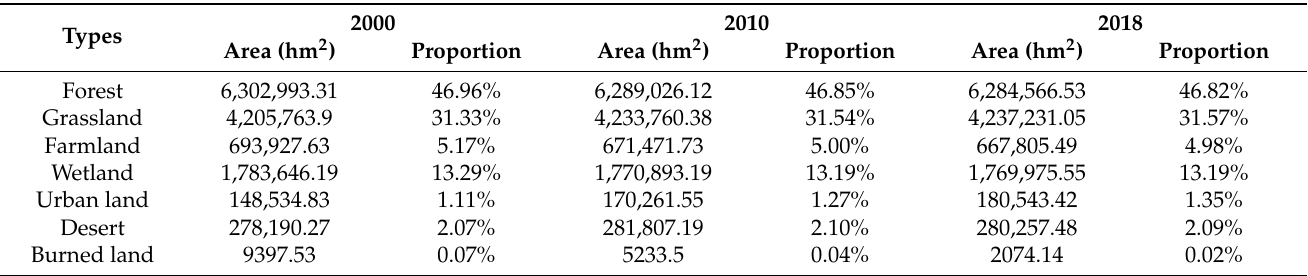
Table 1. Changes in the area and proportion of land cover types from 2000 to